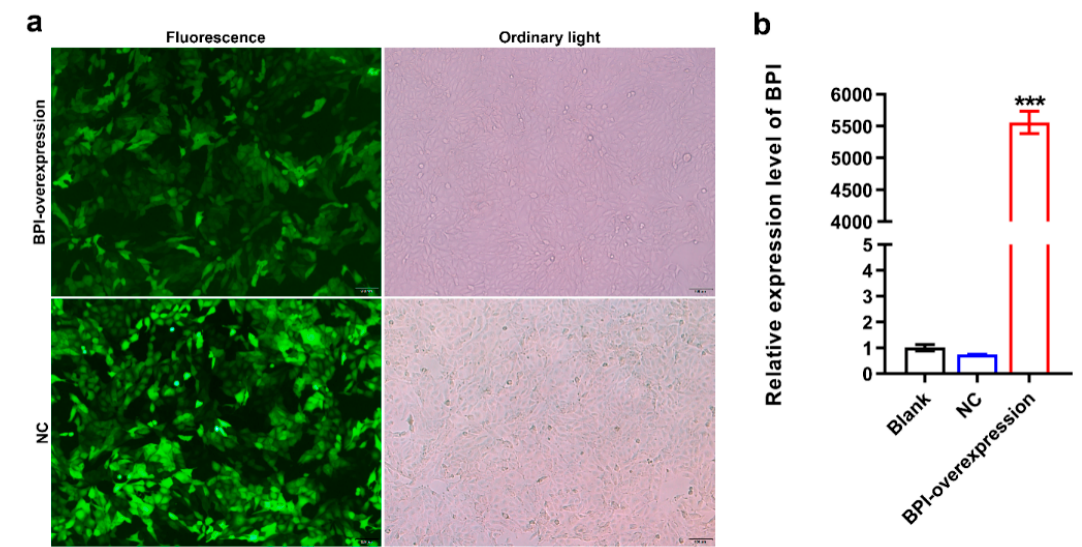
Figure 2. Preparation of BPI -overexpressing PK15 cells. ( a ) Green fluorescent protein (GFP) expression in the indicated PK15 cells was assessed at 96 h following lentiviral transduction. ( b ) BPI expression was measured via qPCR. Blank: untreated control group, NC: PK15 cells transfected with the negative control lentivirus (pGLV5-NC), BPI-overexpression: PK15 cells transfected with the BPI gene overexpression lentivirus (pGLV5-BPI). Samples were analyzed in triplicate. Data are means ± standard deviation. *** p <